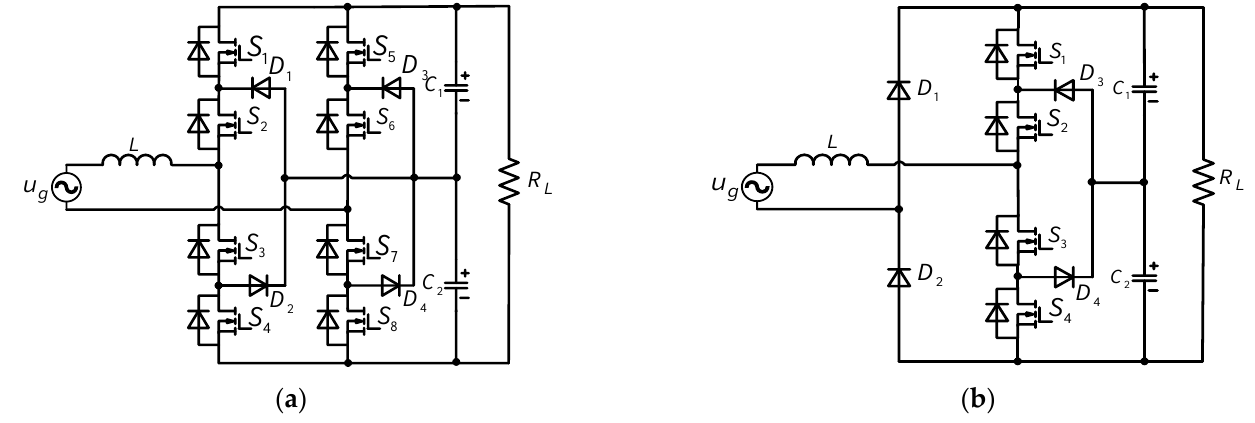
Figure 1. Two typical single-phase three-level PFC topologies. ( a ) TTL-PFC. ( b ) UTL-PFC.